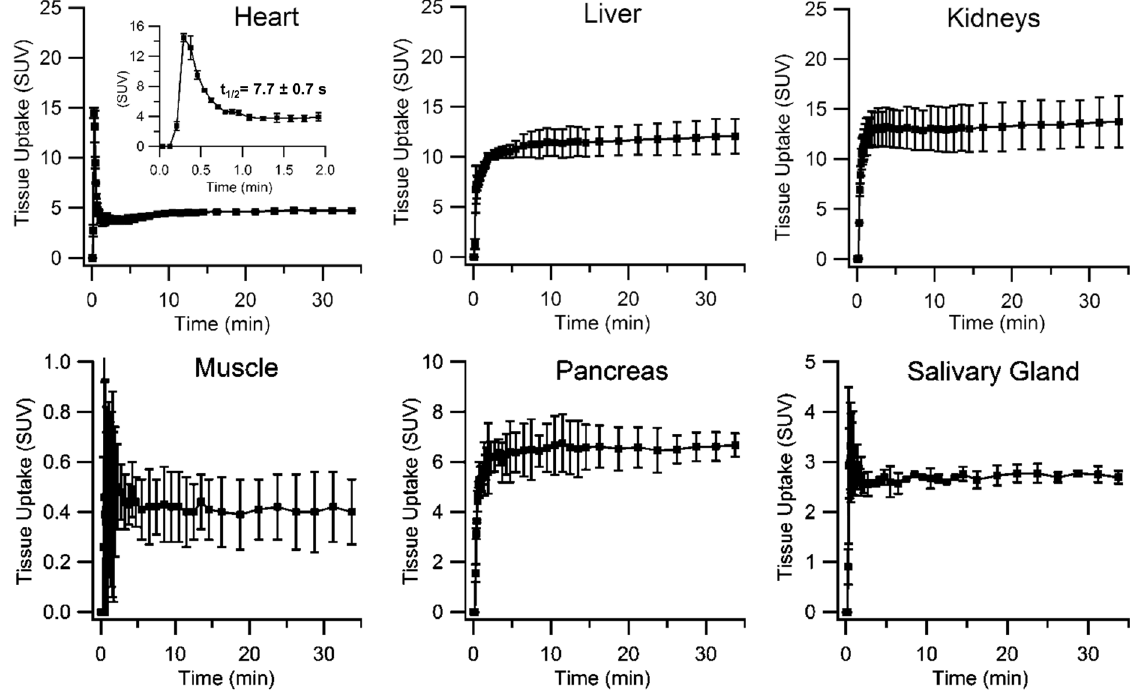
Figure 2. Dynamic PET time-activity curves (TACs) of organ ROIs in ICR mice (n = 2, mean ± SD) injected with a rapid intravenous bolus of 51 Mn(II), imaged for 30 minutes post-injection.